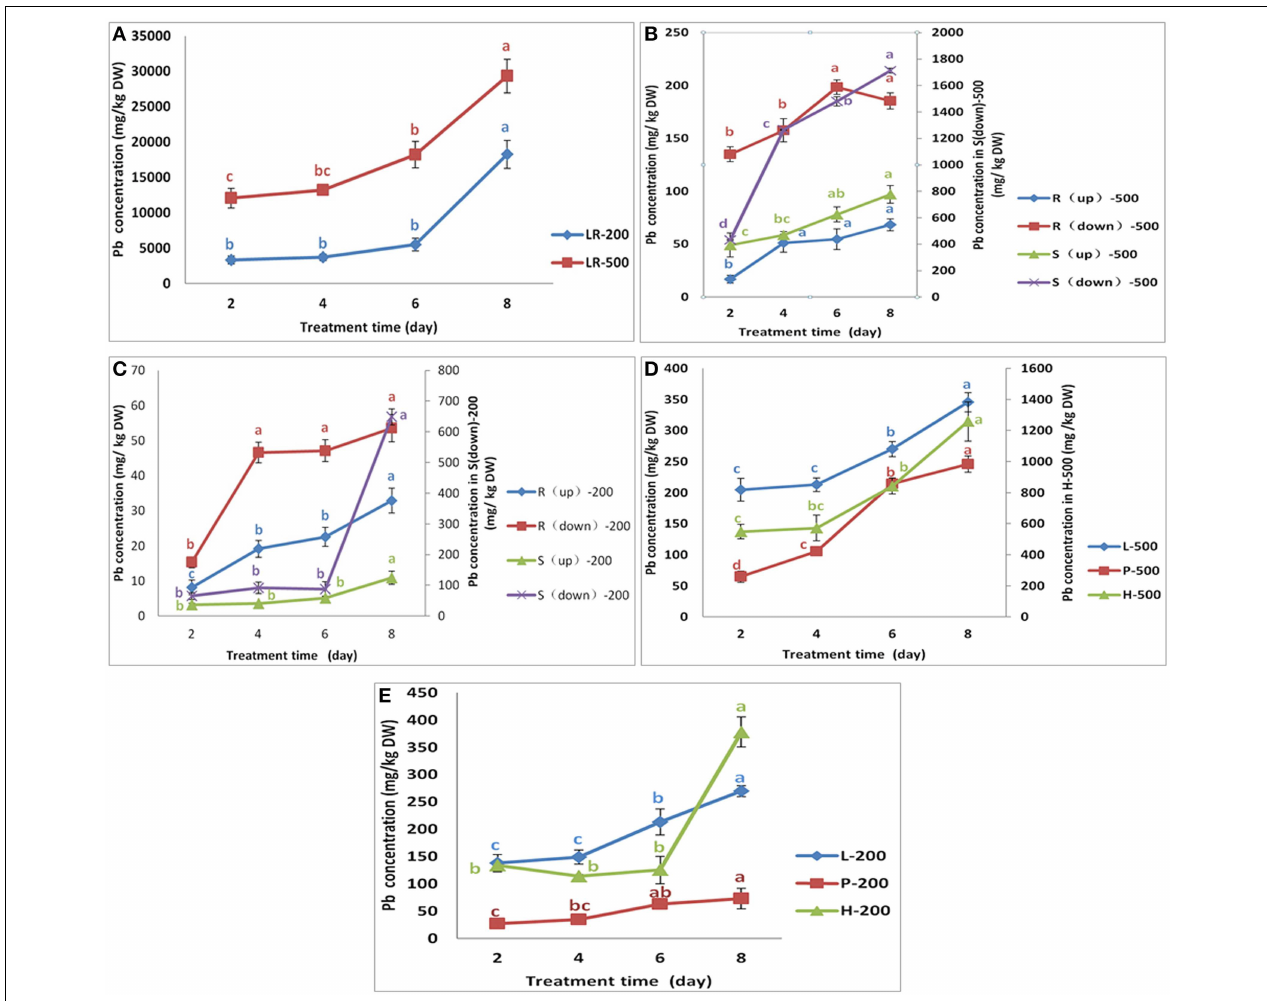
FIGURE 2 | Variation in the Pb concentration in different parts of NAU-XHT. Panel (A) represents the Pb concentration in lateral roots (LR). LR-200 and LR-500 were lateral roots treated with 200mg/L and 500mg/L Pb(NO 3 ) 2 , respectively. Panels (B,C) represent the Pb concentration in root flesh and skin(S) treated with 500mg/L and 200mg/L Pb(NO 3 ) 2 , respectively. R(up)-500 and S(up)-500 were root neck and skin; R(down)-500 and S(down)-500 were true root and skin;